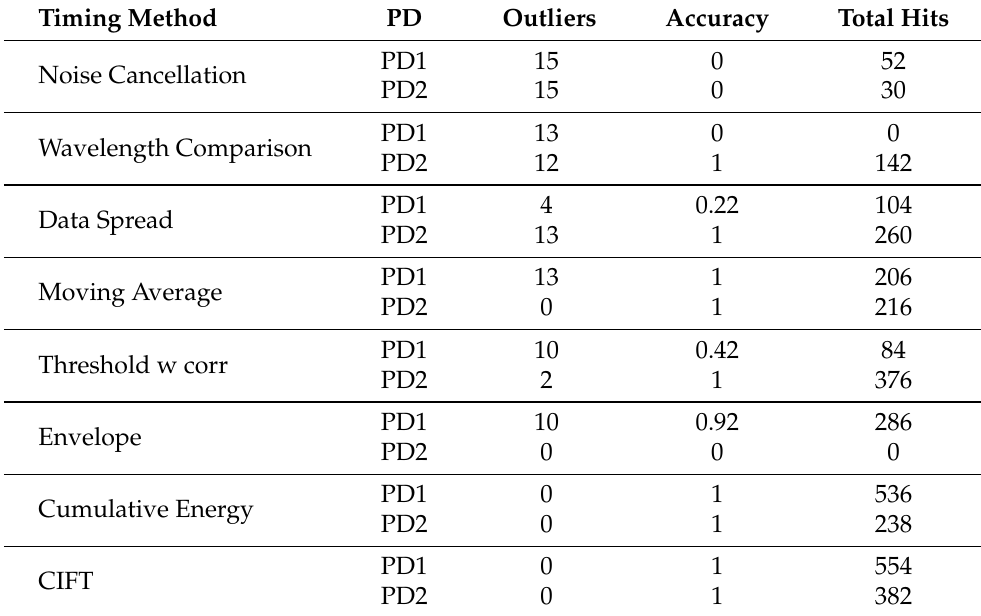
Table 2. Localization (table lookup) results with different timing methods and 500mm tolerance.